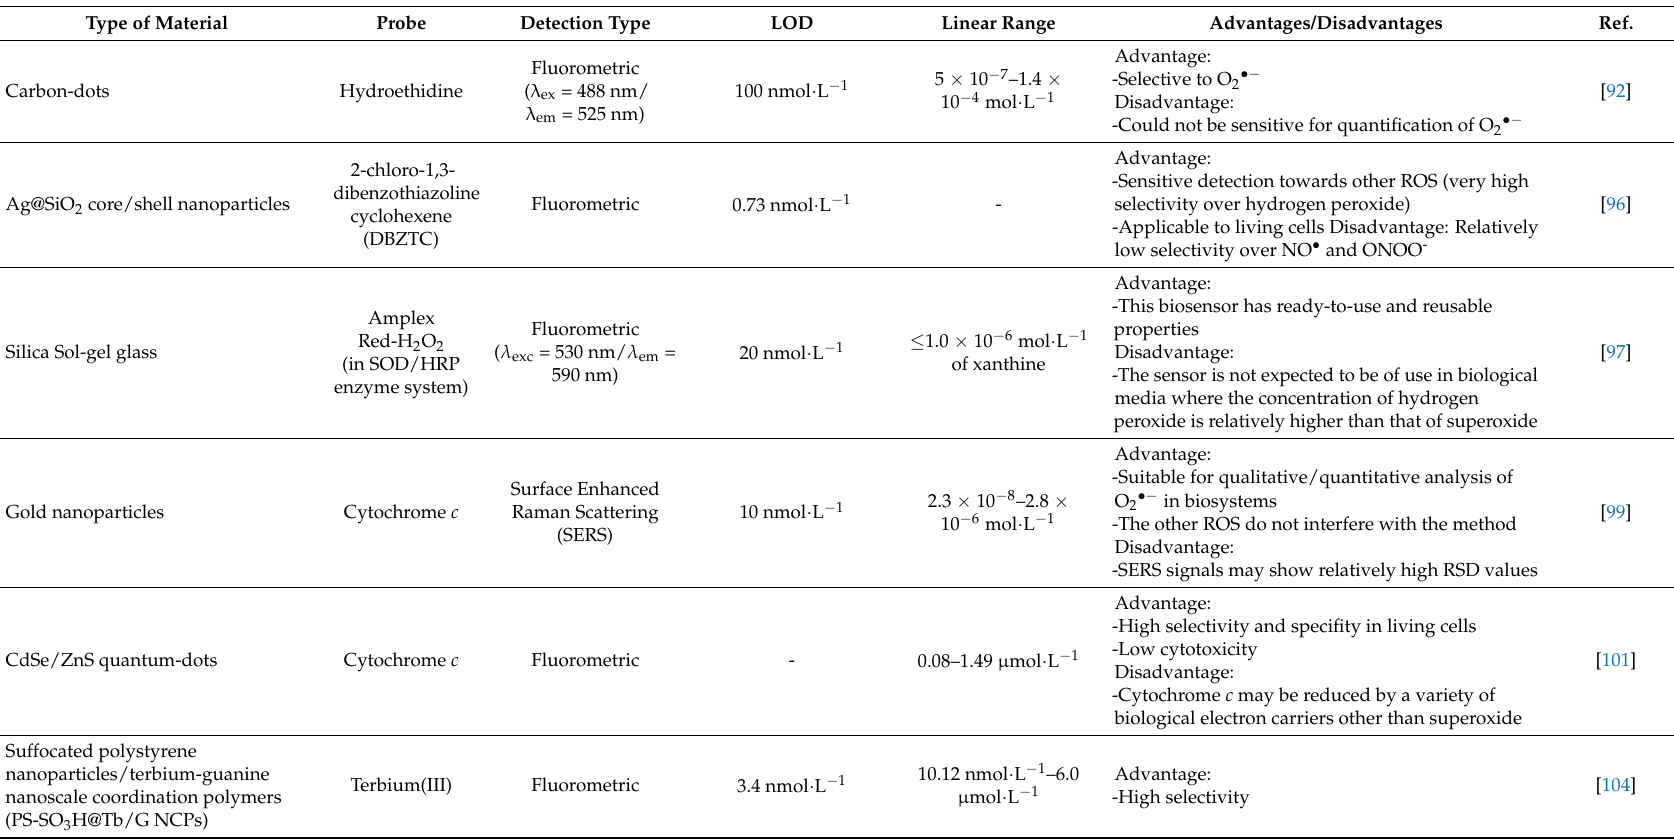
Table 4. Nanoprobes and sensors for detecting superoxide anion